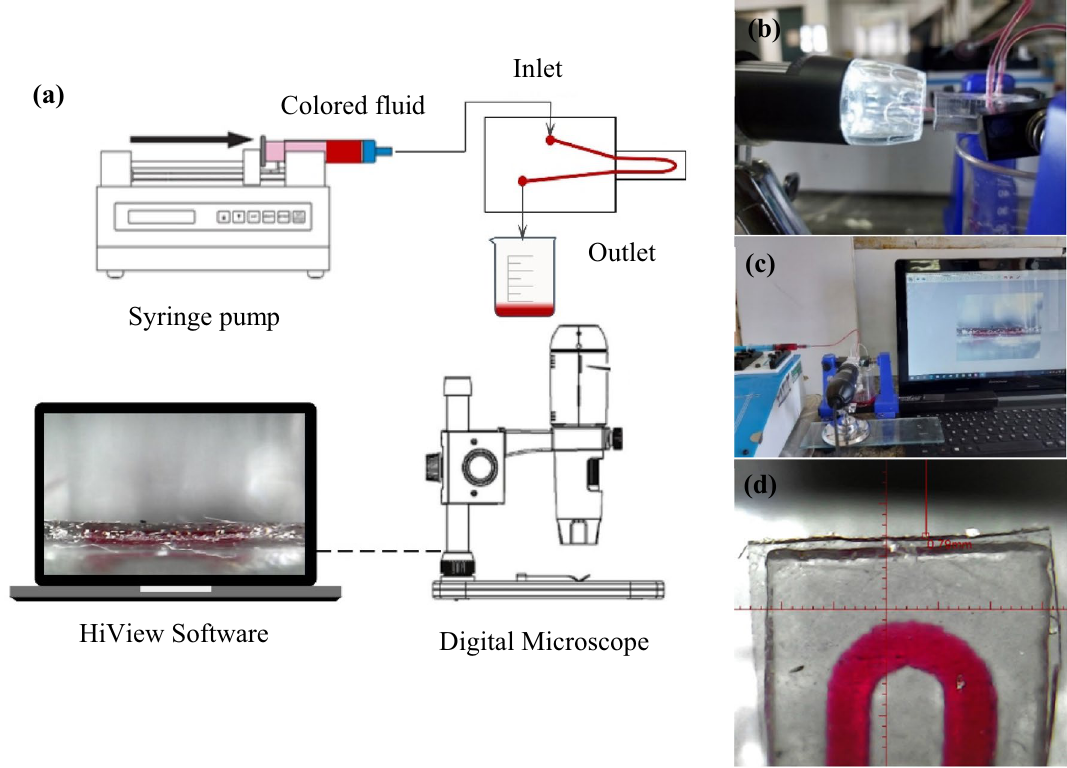
Figure 4. ( a ) Schematic of the experimental setup for flow measuring by microcantilever, (b), (c) photography system, and ( d ) measuring the vertical displacement of the curved cantilever by HiView v.1.4 software (http:// www. hvscam.